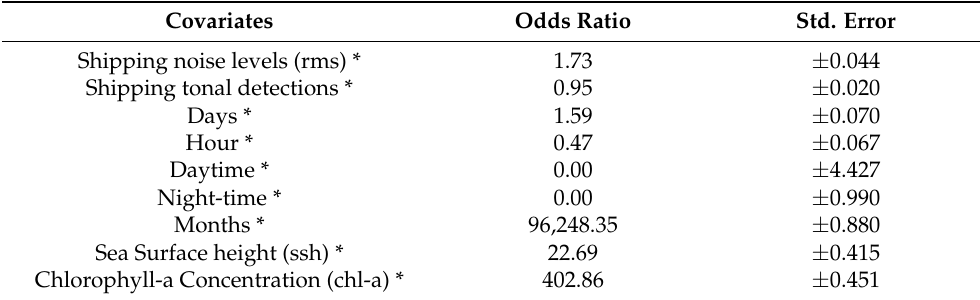
Table 4. Results of the logistic regression with significant explanatory variables for fin whale detections.